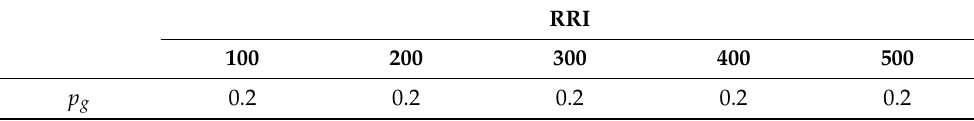
Table 6. Generation pattern